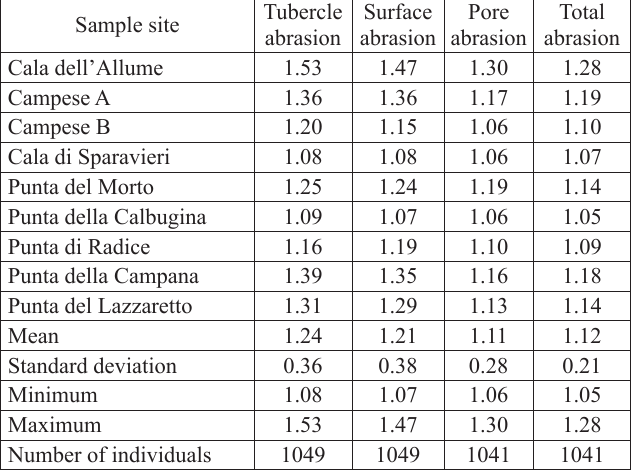
Table 4. Mean taphonomic values of test characteristics with respect to sample sites.